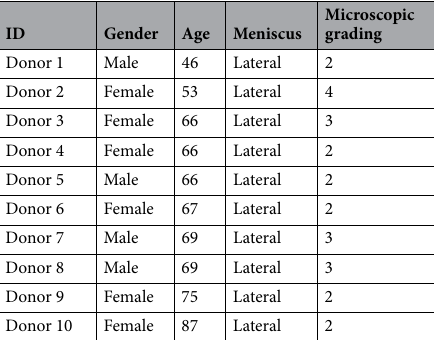
Table 1. Demographics of donors from which samples were